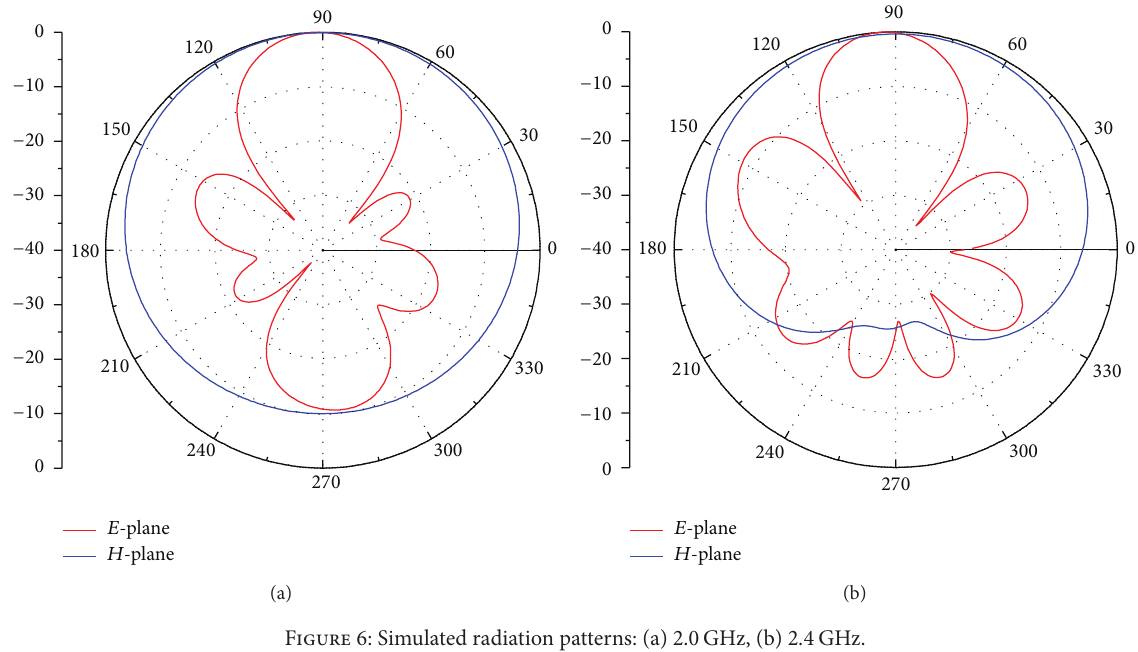
Figure 6: Simulated radiation patterns: (a) 2.0 GHz, (b) 2.4 GHz.